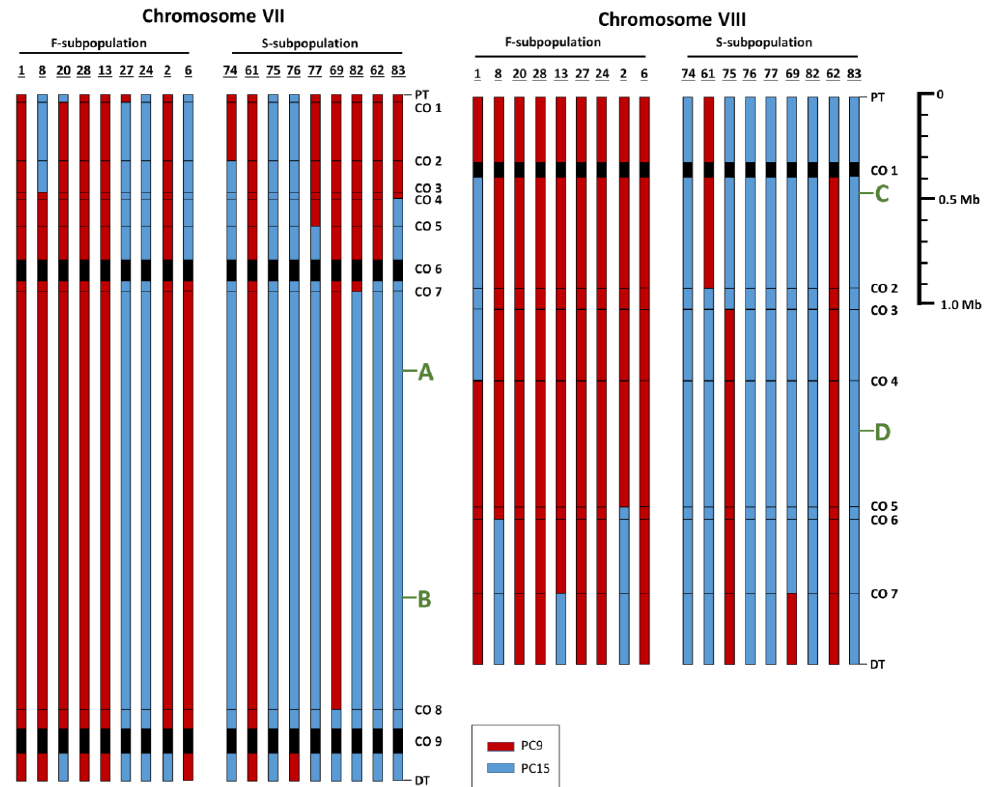
Figure 2. SNP haplotypes of chromosomes VII and VIII for the nine fast- and nine slow-growing monokaryons under study. For each monokaryon, the colors indicate the chromosome fragments derived from MkPC9 (red) and MkPC15 (blue) protoclones. CO indicates crossover regions (listed in sequential order) from the Proximal (PT) to the Distal Telomere (DT). Black lines and areas correspond to crossover regions smaller and greater than 50 kb, respectively. Green letters indicate the mapping position of Sod1 (A), Aox (B), Cyc7 (C), and Cox5B (D).